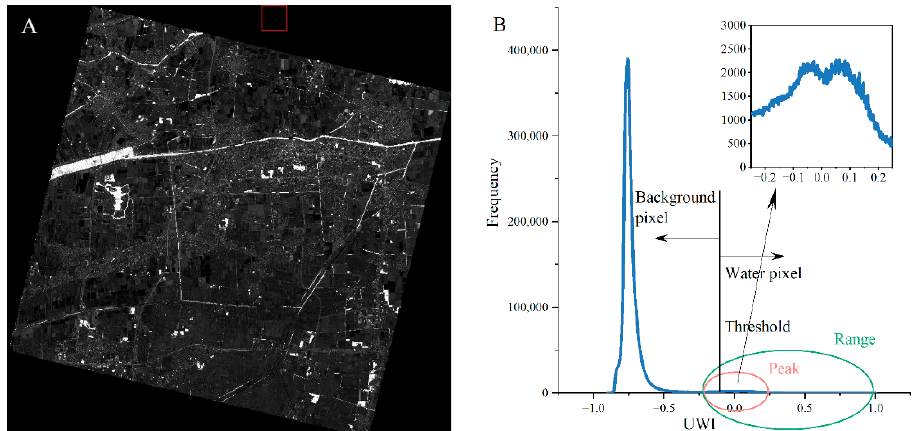
Figure 3. UWI image ( A ) and histogram of its pixels’ frequency distribution ( B ). In ( A ), bright colors are water bodies and shadows, while dark color is the background.